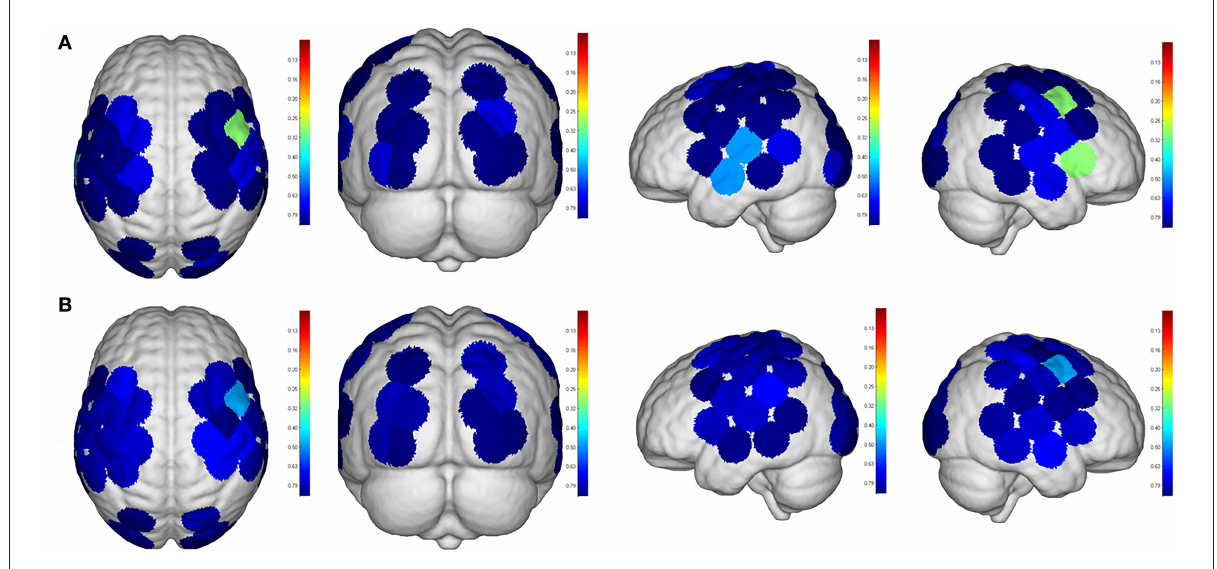
FIGURE7 Comparisons of cortical activation between R1 and R2. R1: Active mode; R2: motor imagery (MI) mode; (A) : β value; (B) : featured value; color bar: 0.1 to 0.9.